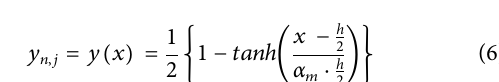
Frontiers in Physics |